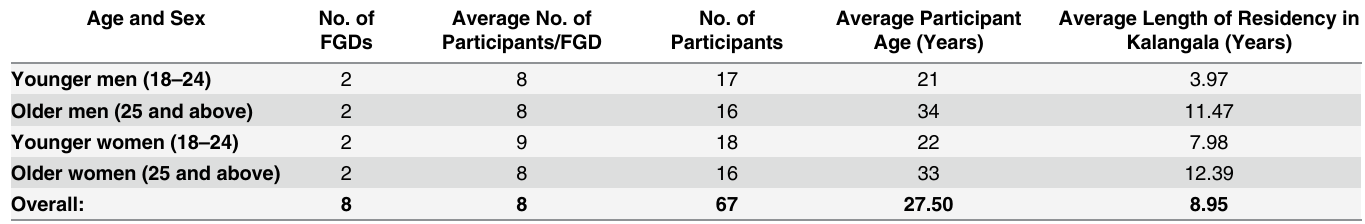
Table 1. Composition of Focus